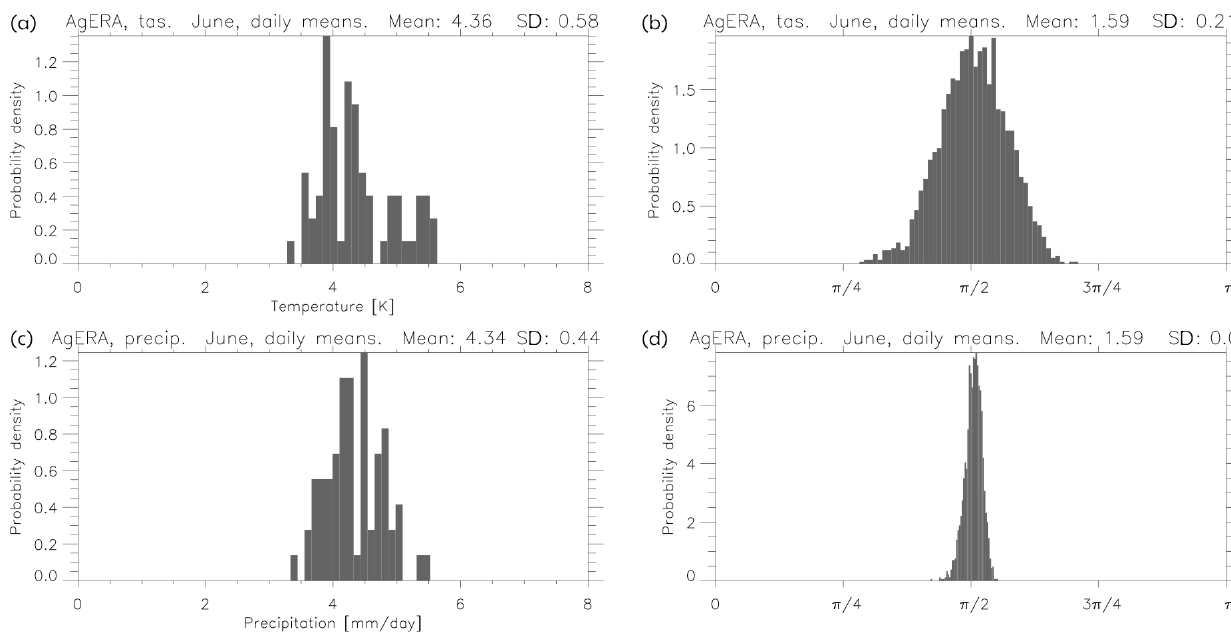
Figure 2. The AgERA data set. Daily means with 5d separation for June 1980–1990. (a, c) Distribution of the lengths. (b, d) Distribution of the angles. (a, b) Near-surface temperature (K). (c, d) Precipitation (mmd − 1